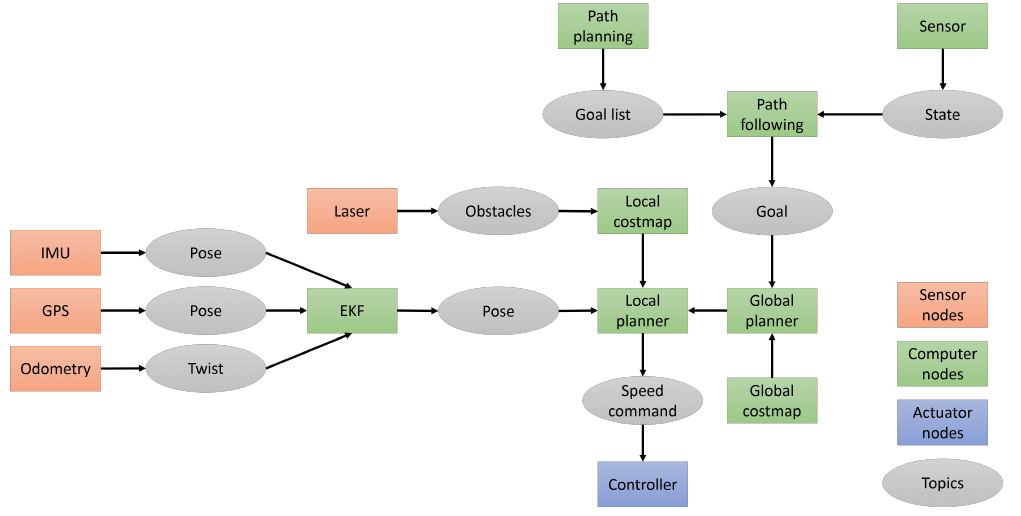
Figure 8. Architecture of the multi-robot sensory